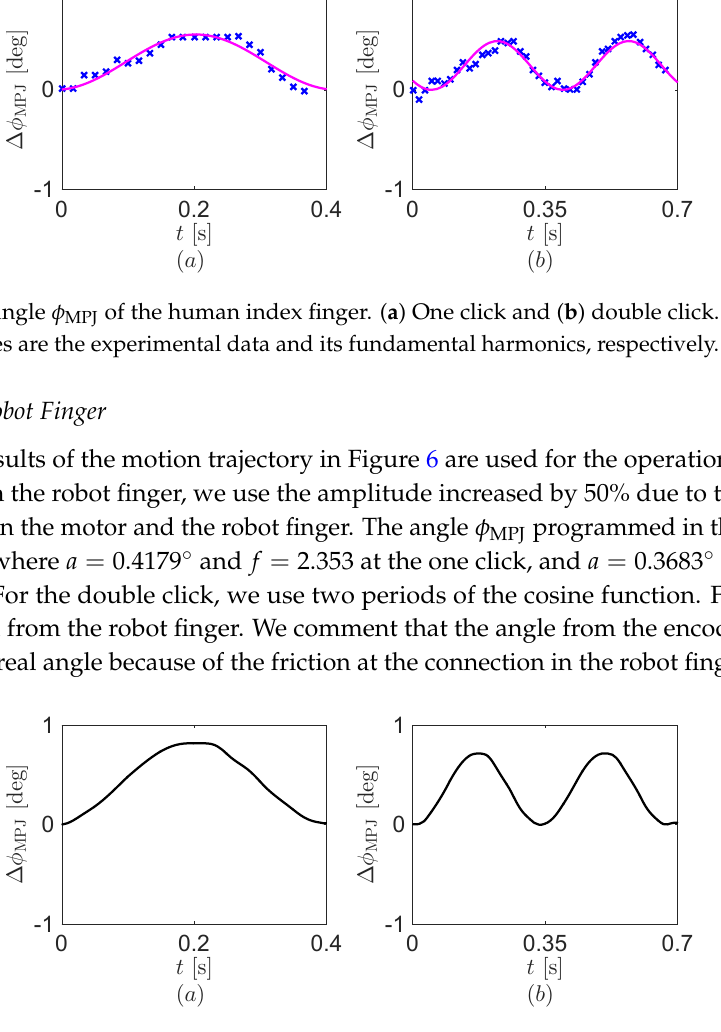
Figure 7. Encoder signal from the robot finger. ( a ) One click and ( b ) double